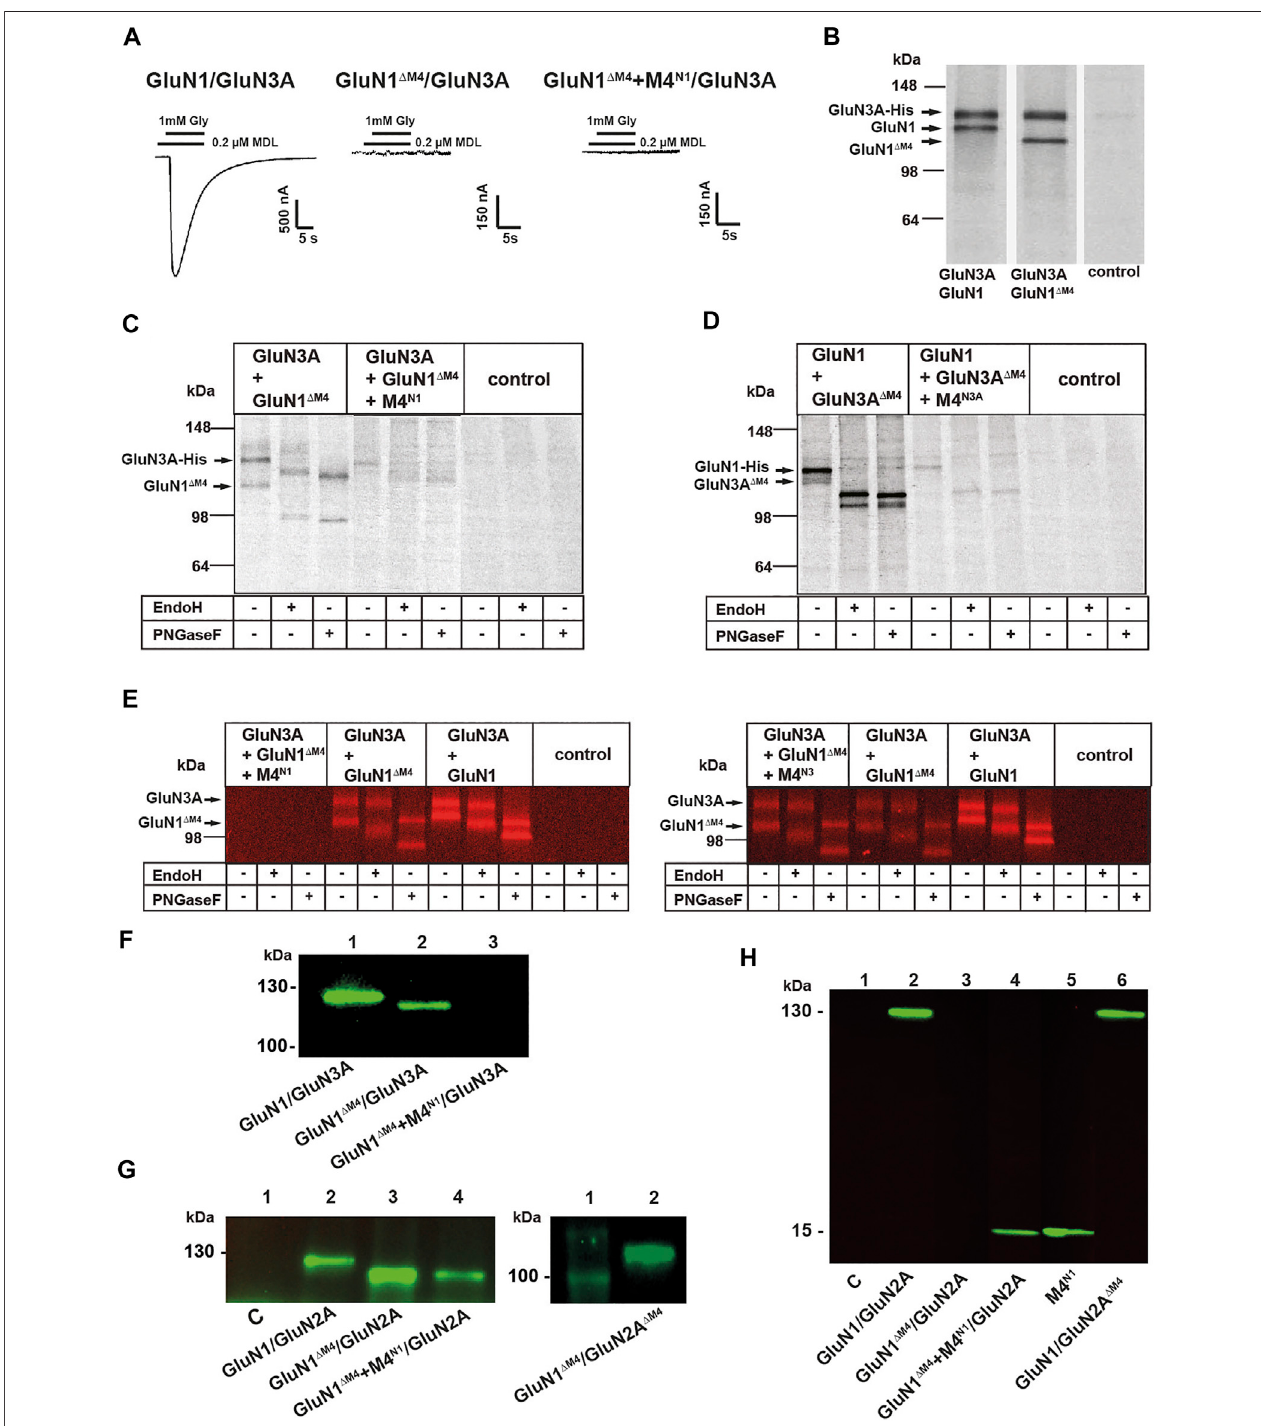
FIGURE 2 | In fl uenceofM4onthesurfaceexpressionofNMDARs. (A) RepresentativeimagesofGluN1/GluN3A,nonfunctionalGluN1 Δ M4 /GluN3A,andGluN1 Δ M4 +M4 N1 / GluN3A receptor combinations. M4 N1 failed to rescue functionality in M4-truncated GluN1/GluN3A receptors. (B) SDS-PAGE of metabolic (35S) methionine-tagged GluN1/ GluN3A and GluN1 Δ M4 /GluN3A receptors with simultaneous puri fi cation of C-terminal His-tagged receptor subunit constructs by metal af fi nity chromatography (His-tag puri fi cationappliestoB – E.).BoththeGluN1/GluN3AandGluN1 Δ M4 /GluN3Areceptorswerecorrectlyexpressed. (C,D) SDS-PAGEofmetabolic(35S)methionine-labeled GluN1/GluN3Areceptorcombinations.GlycosylationstatuswasdeterminedbyPNGaseForEndoHtreatmentandshowedthatGluN1 Δ M4 /GluN3AandGluN1/GluN3A Δ M4 were N-glycosylated,indicatingcellsurfacelocalization.Co-expressionoftherespectiveM4segmentresultedinimpairedreceptorexpressionorbiogenesisintheER. (E) SDS-PAGEof Cy5 surface-stained GluN1/GluN3A and GluN1 Δ M4 /GluN3A and GluN1 Δ M4 +M4 N1 /GluN3A receptors (left) and GluN1/GluN3A and GluN1 Δ M4 /GluN3A and GluN1 Δ M4 +M4 N3A /